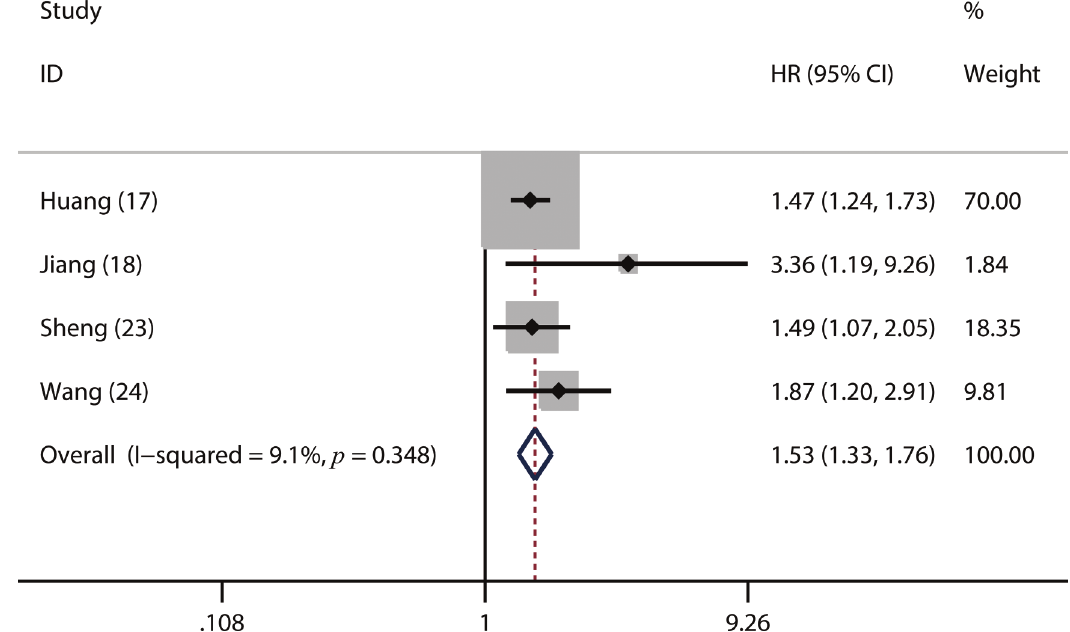
Figure 3 - Forest plot of the hazard ratio (HR) for the association between the plasma fibrinogen level and disease-free survival (DFS) in patients with lung cancer.